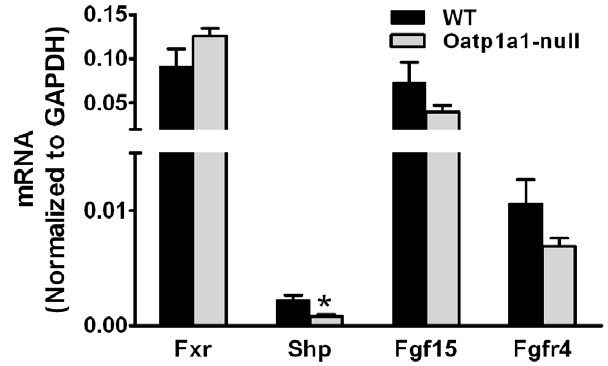
Figure 6. mRNA of Fxr, Shp, and Fgf15 in ilea as well as Fgfr4 in livers of mice. Total RNA from ilea and livers of male WT and Oatp1a1- null mice (n=5/group) was analyzed using multiplex suspension array. The mRNA of each gene was normalized to GAPDH. All data are expressed as mean 6 S.E. of five mice in each group. *, statistically significant difference between WT and Oatp1a1-null mice ( p ,